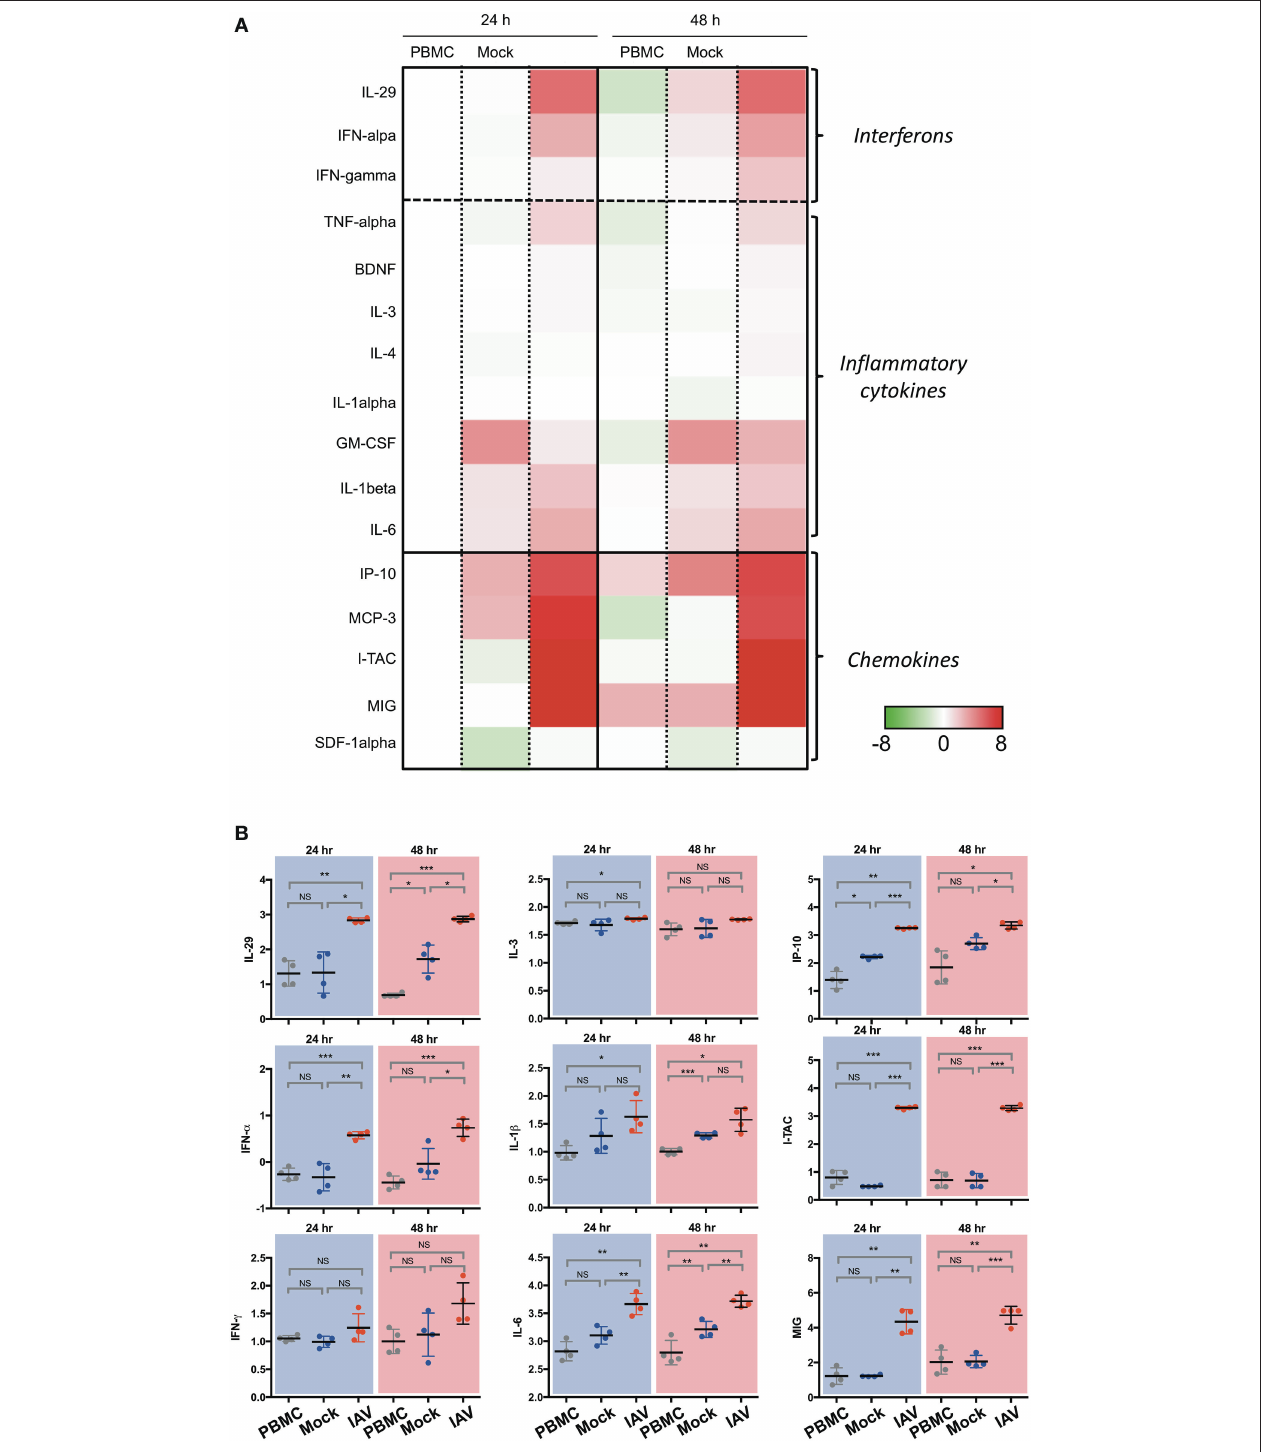
FIGURE 2 | Luminex analysis of culture supernatants of PBMC, Mock, and IAV infection at 24 and 48h. (A) Heatmap of interferon, selected cytokines and chemokines. The colors indicate the relative change (log2 fold change) of average analyte concentration in supernatant of PBMC, Mock, and IAV infection at 24 and 48h compared to PBMC at 24h. For each analyte, the relative concentration is shown as a scale from 8 and − 8. (B) Statistically significantly upregulated cytokine and chemokine concentrations measured by Luminex multiplex assay on a custom 23-plex plate. Cytokines and chemokines are reported in log10 pg/ml. PBMC, peripheral blood mononuclear cell only sample; Mock, co-culture sample without H3N2-infection of nasal epithelium; IAV, co-culture of H3N2-infected nasal epithelium. All data represent the mean ± SD. *** P < 0.001; ** P < 0.01; * P < 0.05; NS, not significant.